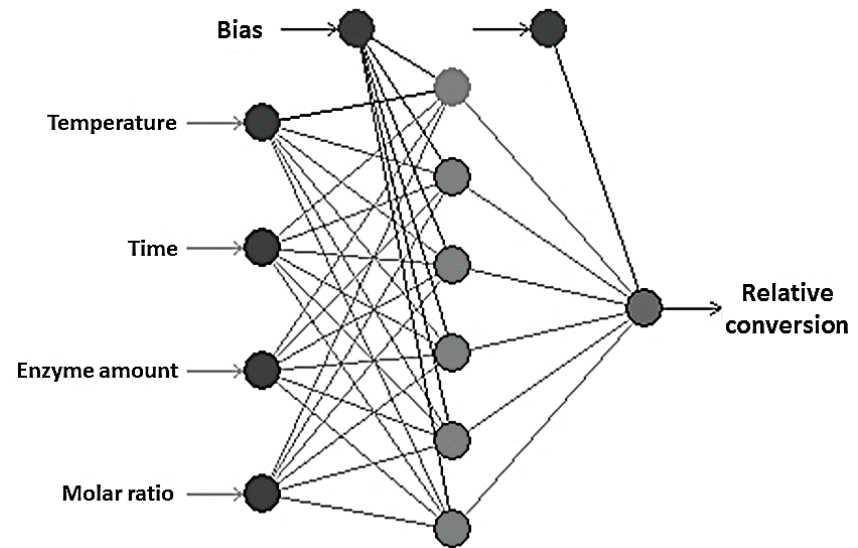
Figure 5. The optimal architecture of multilayer feed-forward neural network. The network contains four inputs (reaction temperature, reaction time, enzyme amount, and molar ratio of retinyl acetate to lauric acid), one hidden layer with six nodes and one output (relative conversion of retinyl laurate).